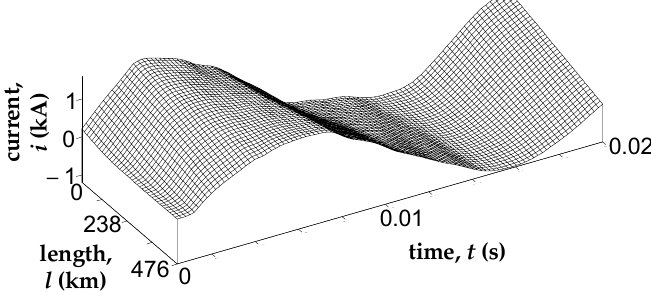
Figure 12. Phase voltage waveforms at the line’s end.